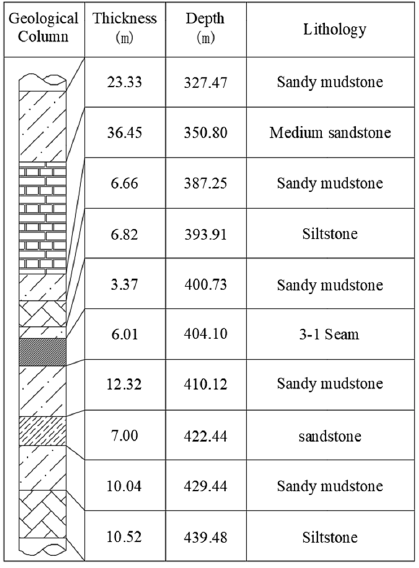
Figure 4. Typical geological column.